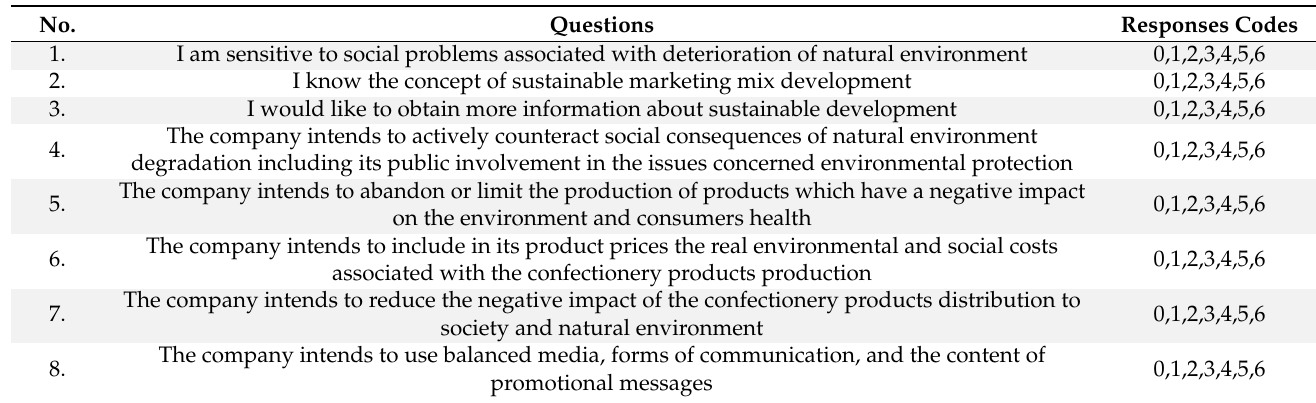
Table A1. The questionnaire